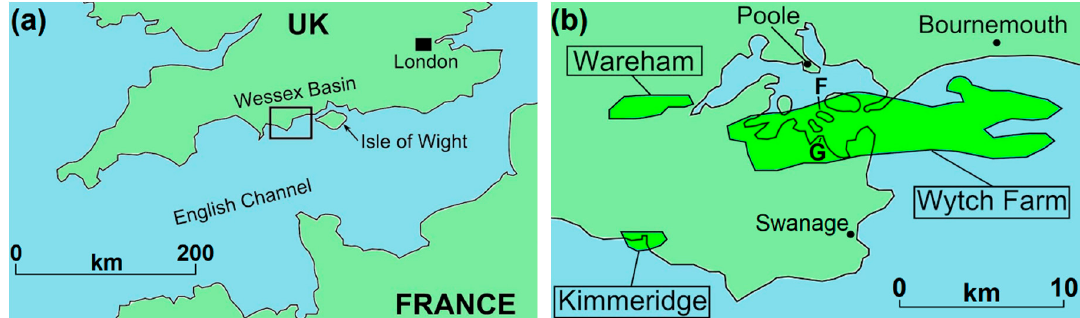
Production denotes the total water produced in each field during 2019. BHT is the mean estimated bottom-hole temperature for each field. Wells denotes the number of wells in each field categorized by the OGA as ‘operating’.